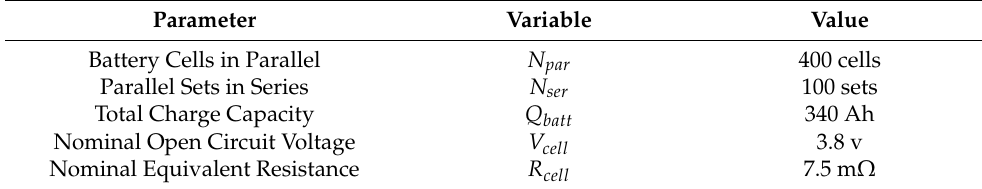
Table 2. Battery model parameters.